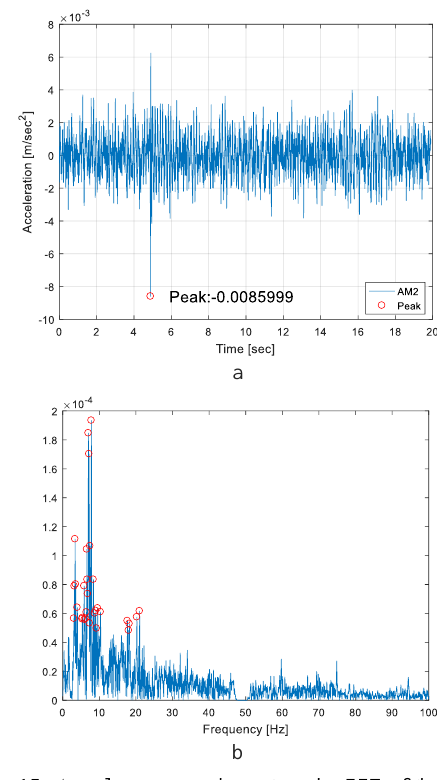
Figure 13. Annual mean peak acceleration at each channel in 2011